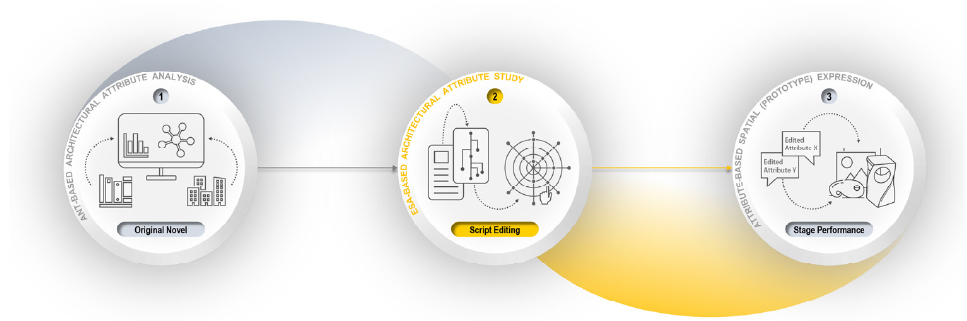
Figure 1. The analysis, editing, and expression of architectural attributes.